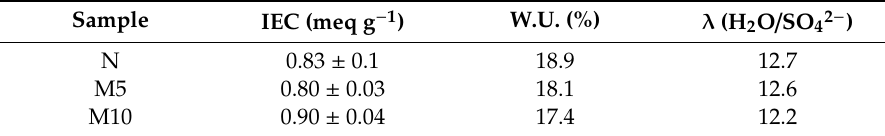
Table 1. Values of WU, IEC and λ of membranes equilibrated at 100% RH.